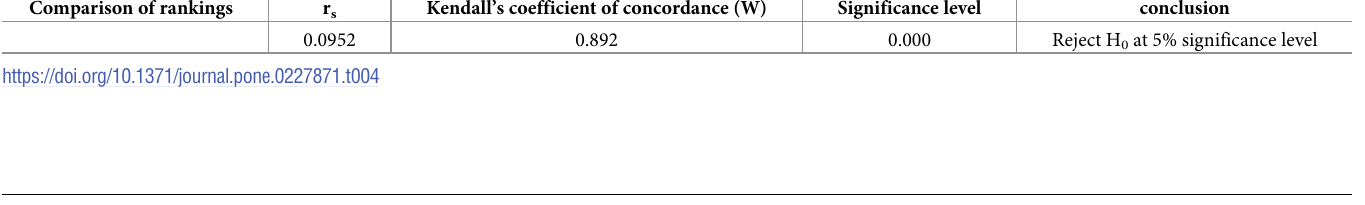
Table 4. Spearman’s rank correlation coefficient. Comparison of